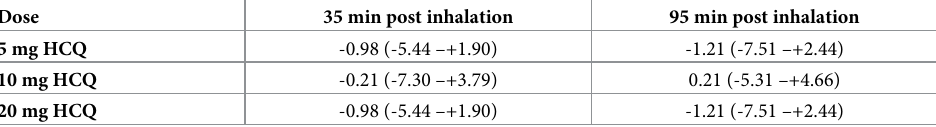
Table 4. Change in FEV1 post inhalation compared to baseline in %: Mean and